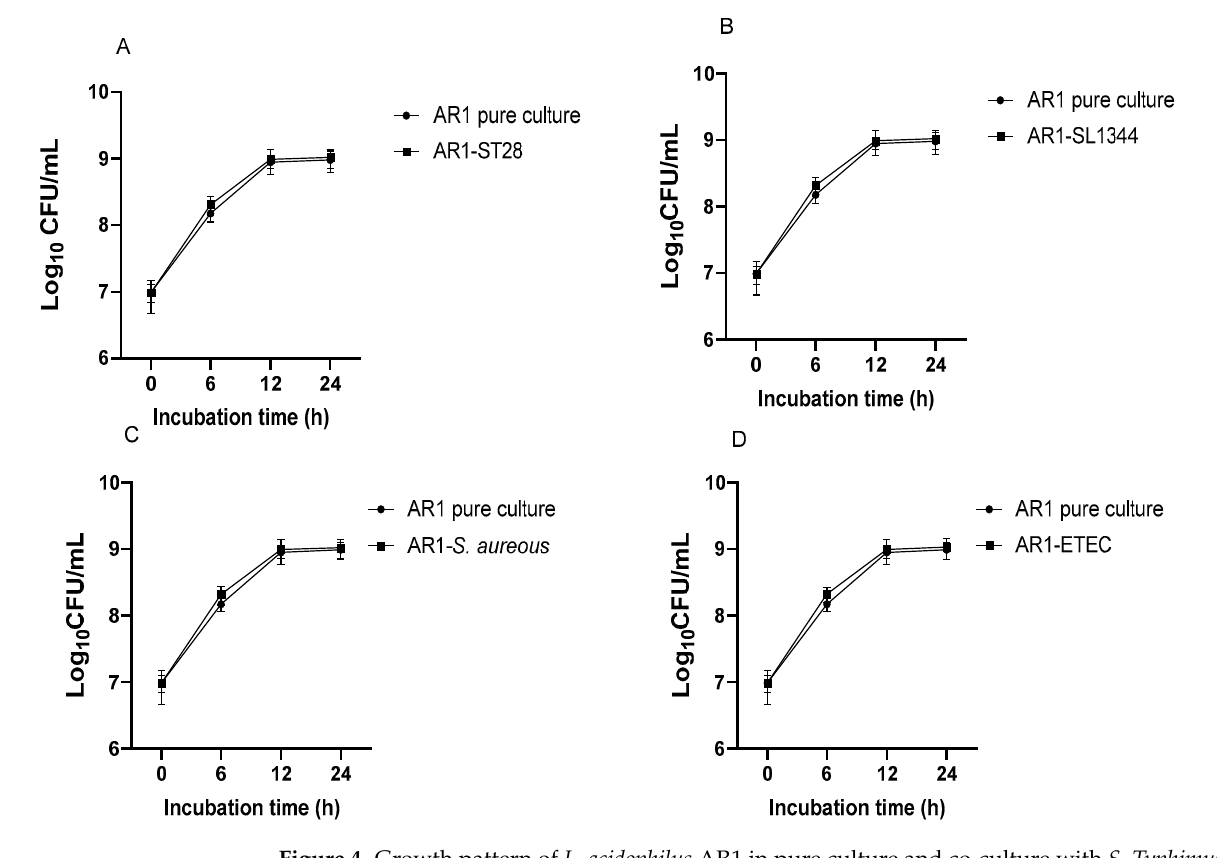
Figure 4. Growth pattern of L. acidophilus AR1 in pure culture and co-culture with S. Typhimurium 14028. ( A ), S. Typhimurium SL1344 ( B ), S. aureus ( C ), and ETEC ( D ).